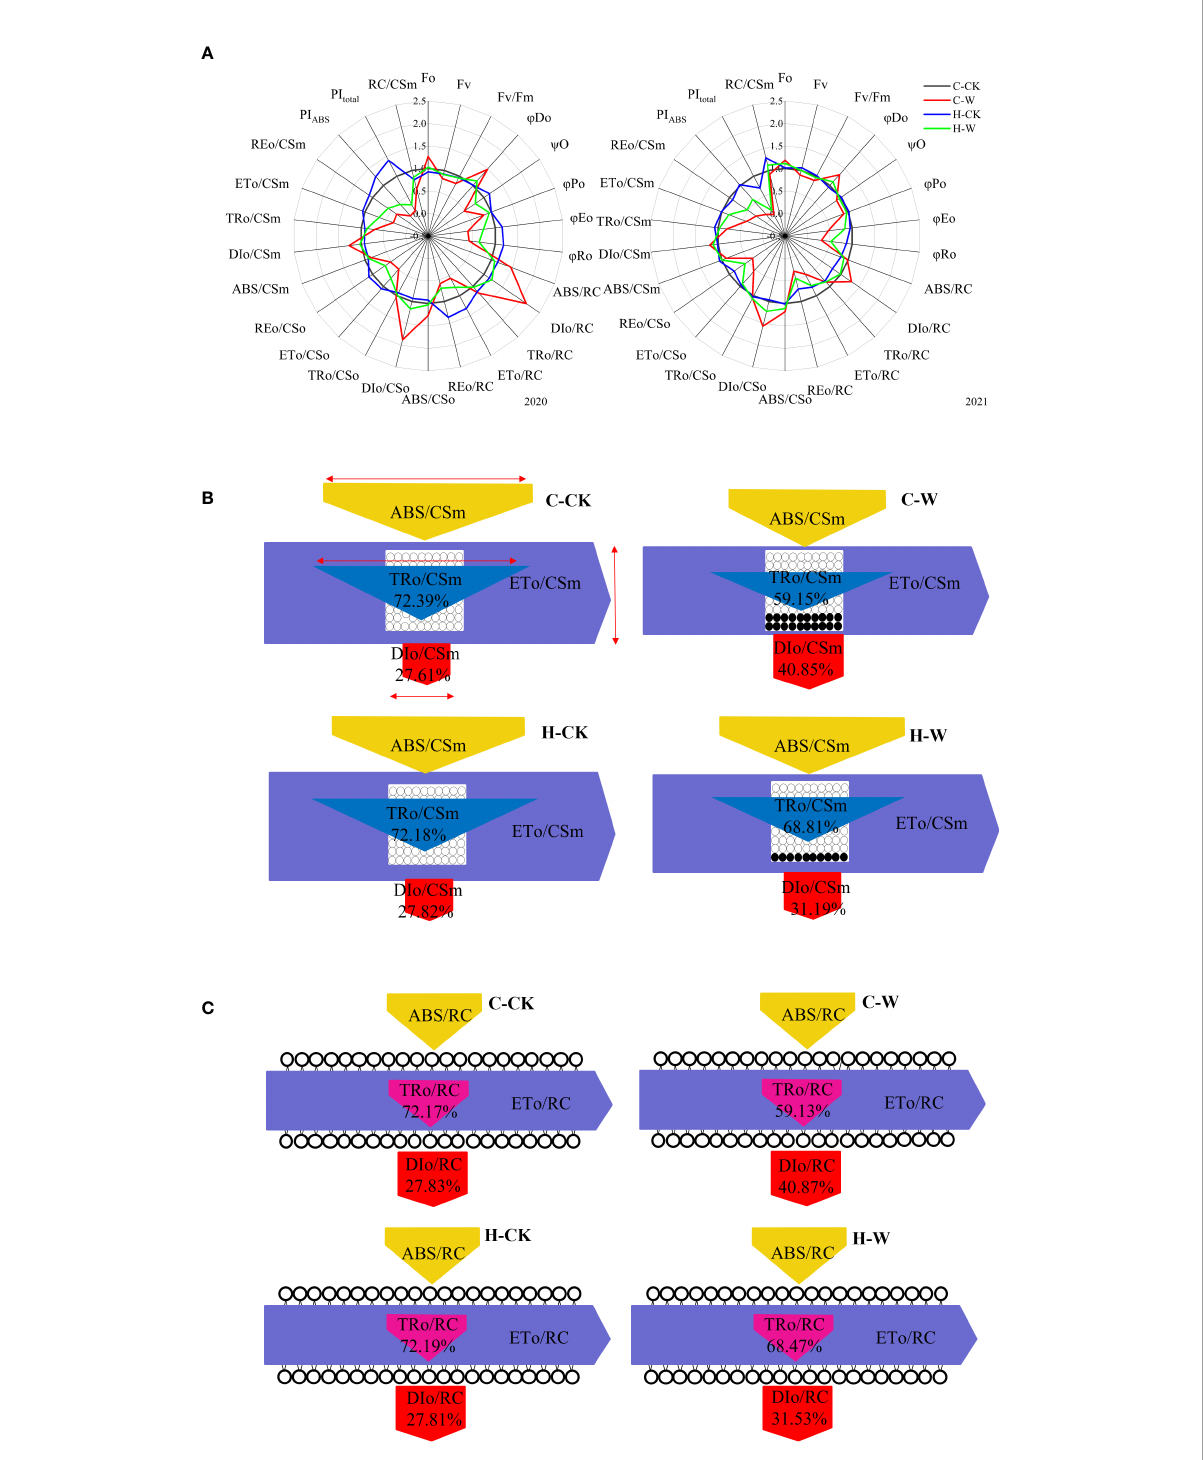
FIGURE 6 PSII biophysical parameters derived by the JIP-test equations. (A) Changes of JIP parameter radar images in 2020 and 2021. Note: The values were calculated relative to the C-CK, taken as 1, and the fl uorescence parameters of other treatments were transformed into the percentage of C-CK fl uorescence parameters. (B) Energy pipeline models of phenomenological fl uxes (per cross-section, CSm) in 2020. The decrease in absorption (yellow), trapping (cyan), and electron transport (purple), can be seen as changes in the width of each arrow (red arrow = scale). The active reaction center is represented by a white circle, and the inactive reaction center is represented by a black circle. (C) Speci fi c energy fl ux (membrane model) in